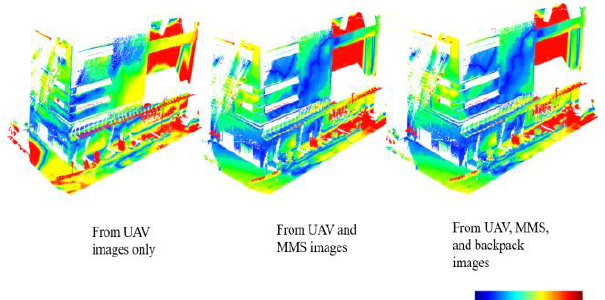
Figure 9. Unsigned CMD of the bottom part of a tall building based on the model from UAV images only, UAV and MMS images, and UAV, MMS, and backpack images.